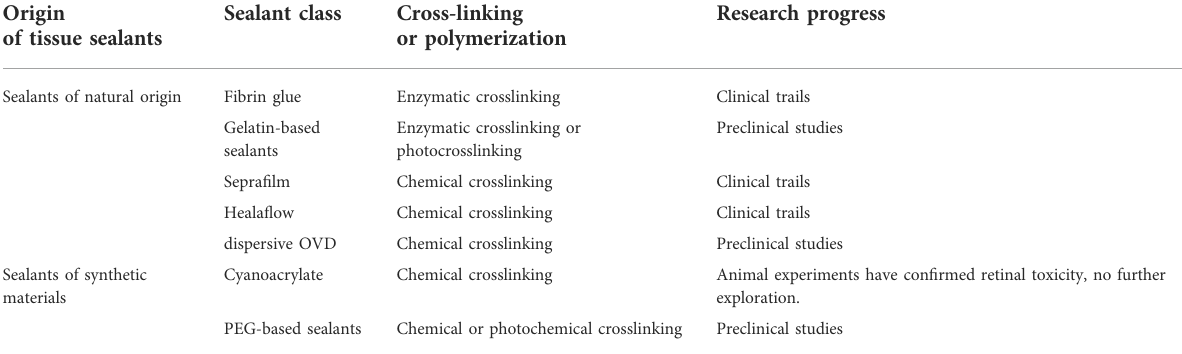
TABLE 1 The summaries of different sealants as retinal patches for RRD surgery